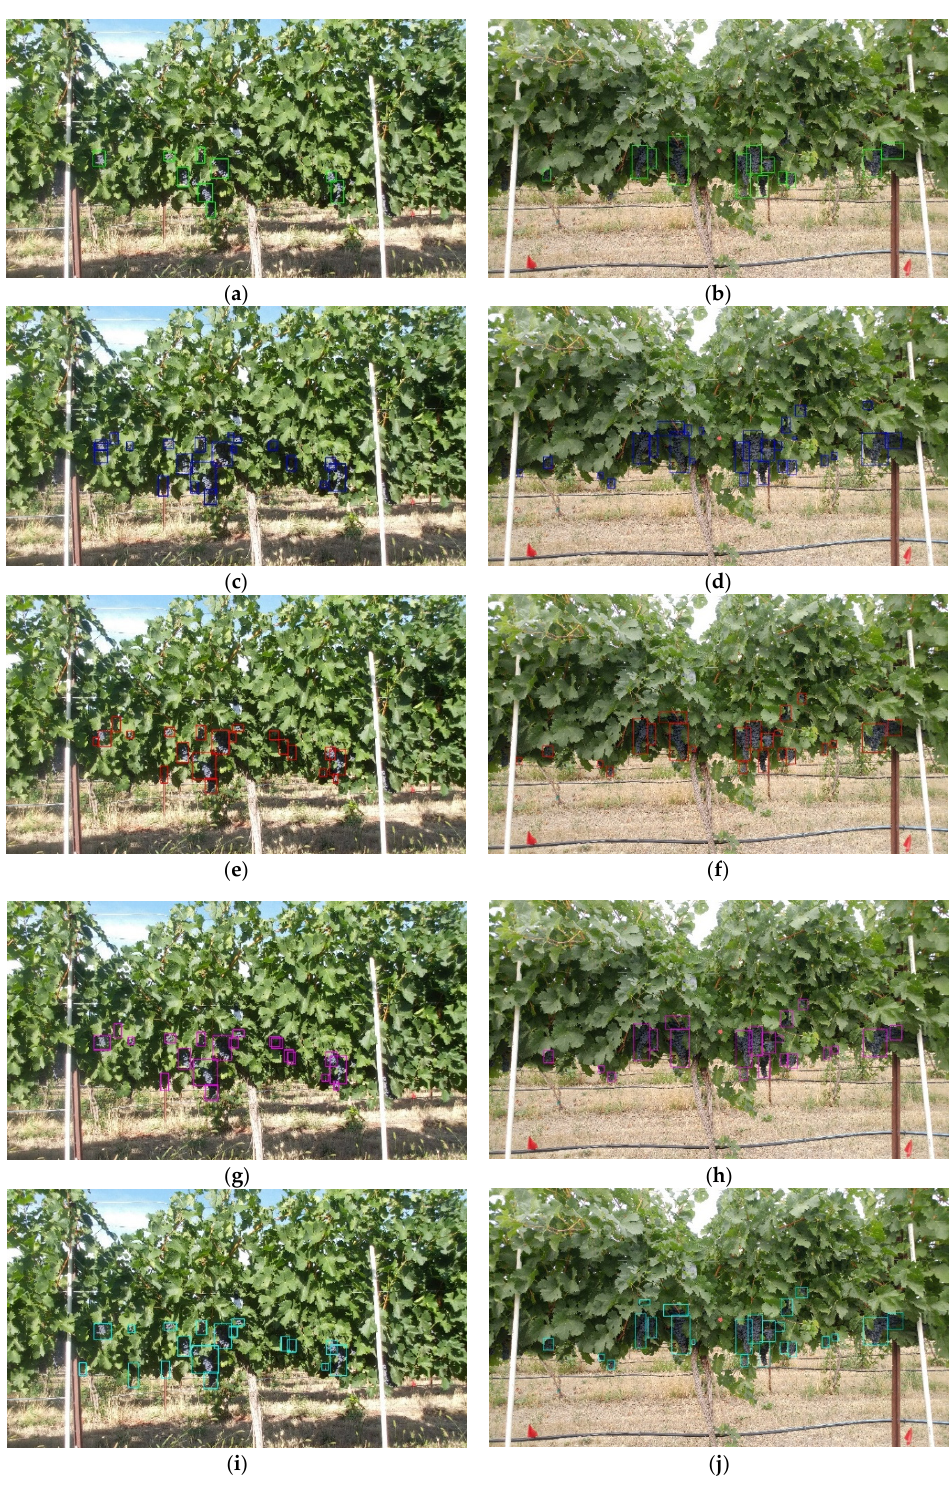
Figure A1. Demonstrations of detection results on the test set of Chardonnay (white variety) using ( a , b ) Faster R-CNN (bounding boxes in green color); ( c , d ) YOLOv3 (in blue color); ( e , f ) YOLOv4 (in red color); ( g , h ) YOLOv5 (in magenta color); and ( i , j ) Swin-transformer-YOLOv5 (in cyan color) under sunny (left) and cloudy (right) weathers.